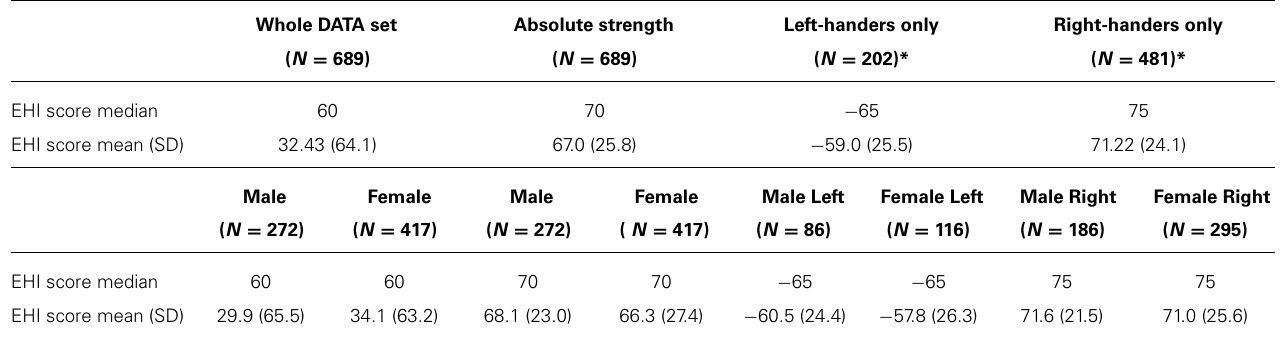
Table 1 | Distribution of EHI scores.